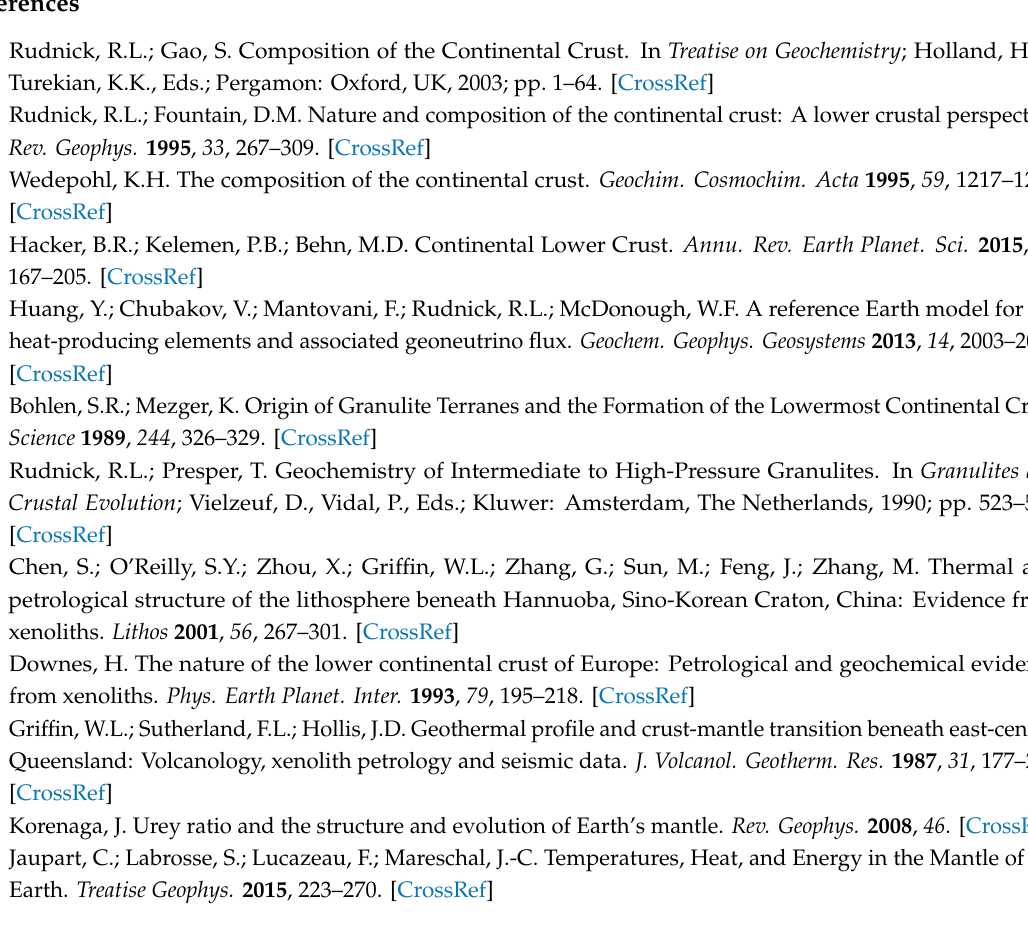
Table S1: Bulk rock major and trace element data of secondary standards from XRF and solution ICPMS analysis, Table S2: Major element data for the secondary standards analysed by EPMA. Table S3: Trace element data for secondary standards analysed by LA-ICPMS, Table S4: Major element data for mineral phases in the KSZ gneiss samples measured by EPMA, Table S5: Trace element data for mineral phases in the KSZ gneiss samples measured by LA-ICPMS, Supplementary Figure S1: BSE maps of the KSZ gneiss